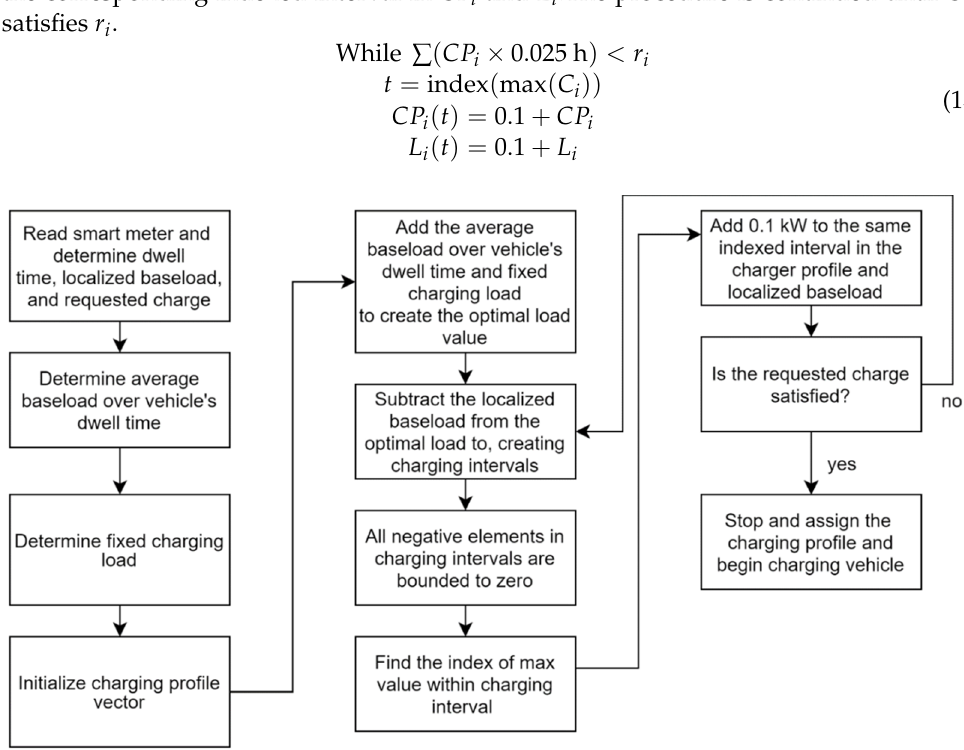
Figure 2. RIVF flow chart.